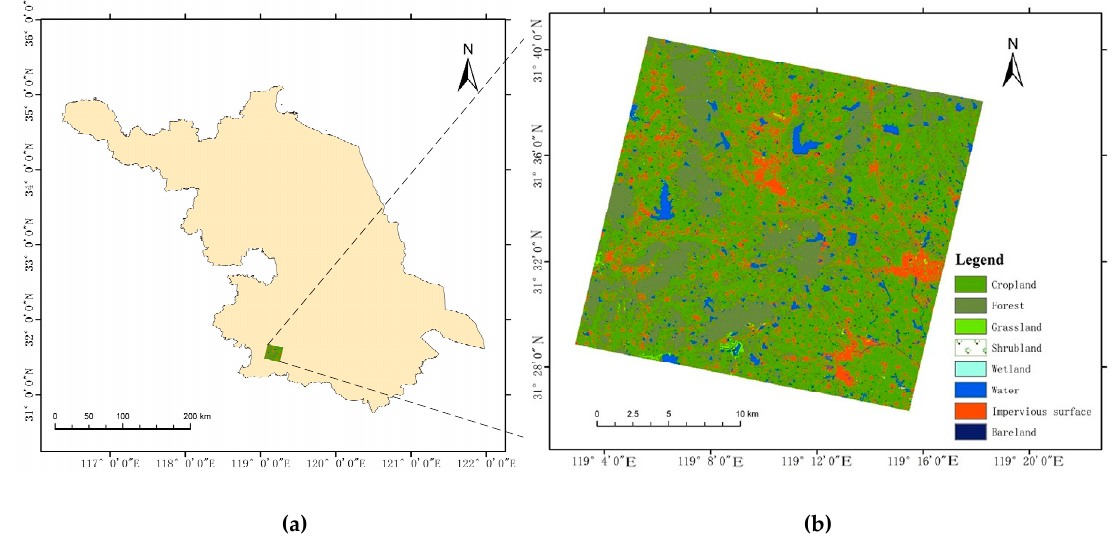
Figure 1. ( a ) Geographical location of the study area and ( b ) major land cover types.